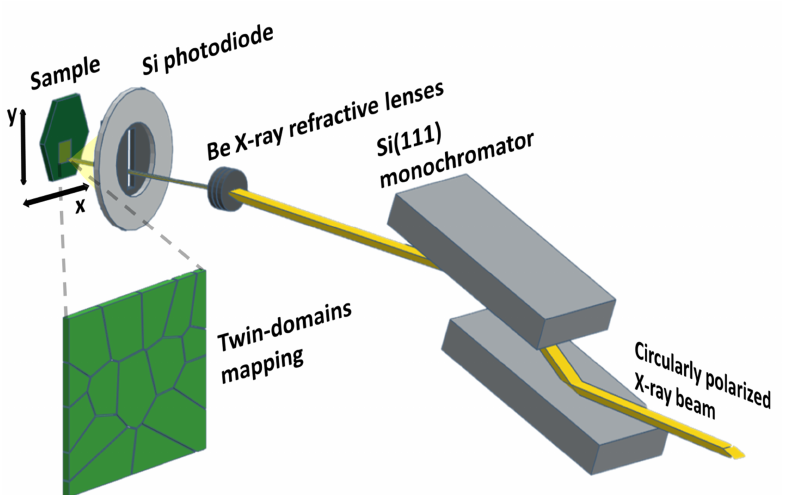
Figure 1. Schematic representation of the XNCD imaging experimental set-up on beamline ID12 (ESRF). A Si(111) monochromator is used to select the desired wavelength from the incoming circularly polarized X-ray beam, and the selected beam is further focused using Be compound refractive lenses [29]. The sample is set such that the trigonal c -axis is parallel to the k -vector of incident beam to avoid the birefringence and linear dichroism effects. The sample crystal is raster- scanned through the focused beam. The experimental signals are recorded by a silicon